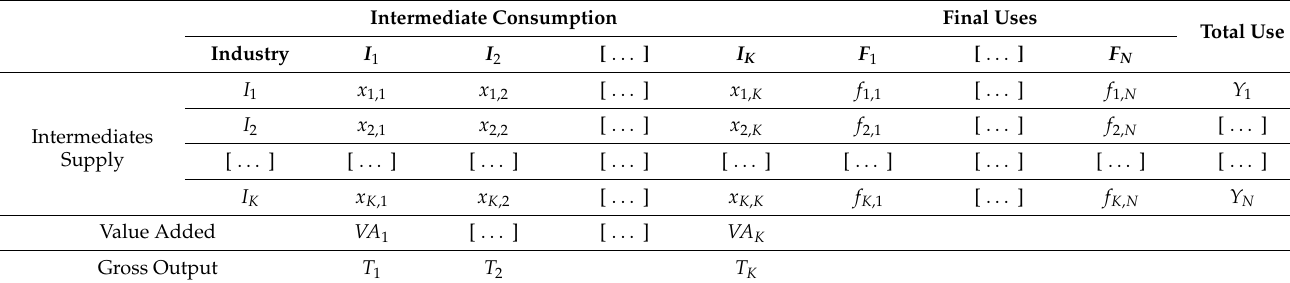
Table 3. Input–output table for a national economy of K